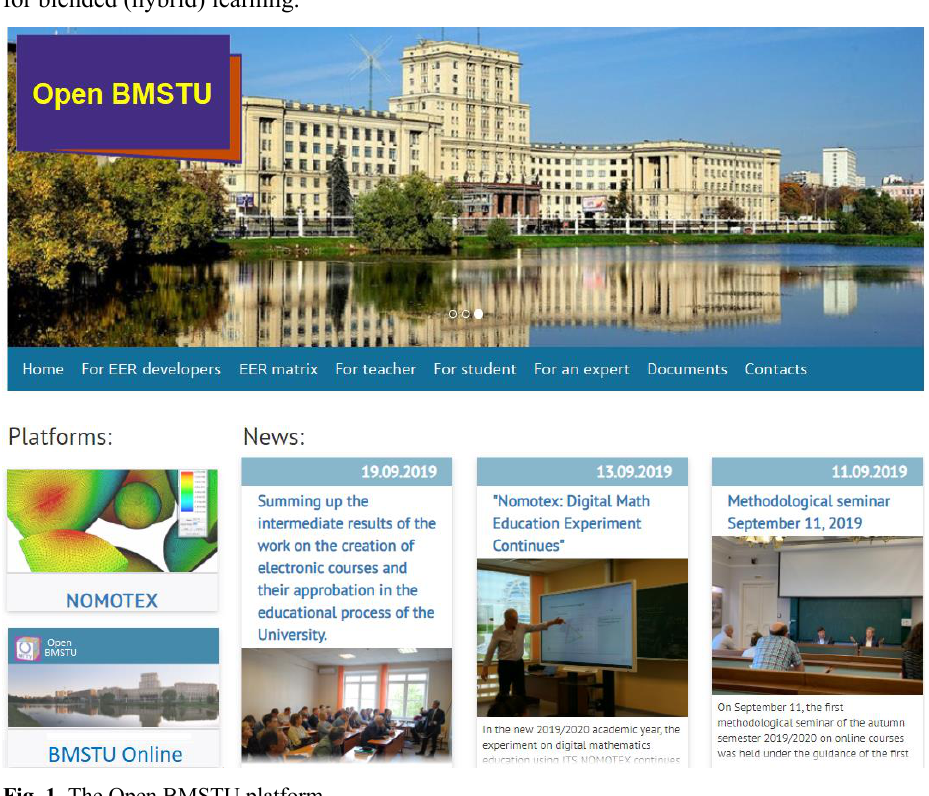
Fig. 1. The Open BMSTU